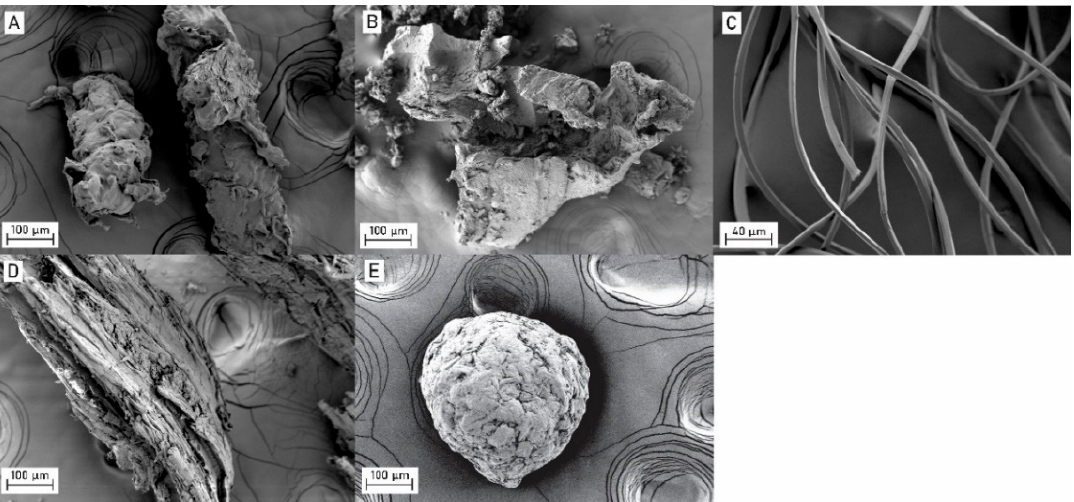
Figure 1. Microplastics and natural particles under the field-emission scanning electron microscope: ( A ) microbeads, ( B ) tire wear particles, ( C ) fibers, ( D ) wood dust, and ( E ) cellulose particles.